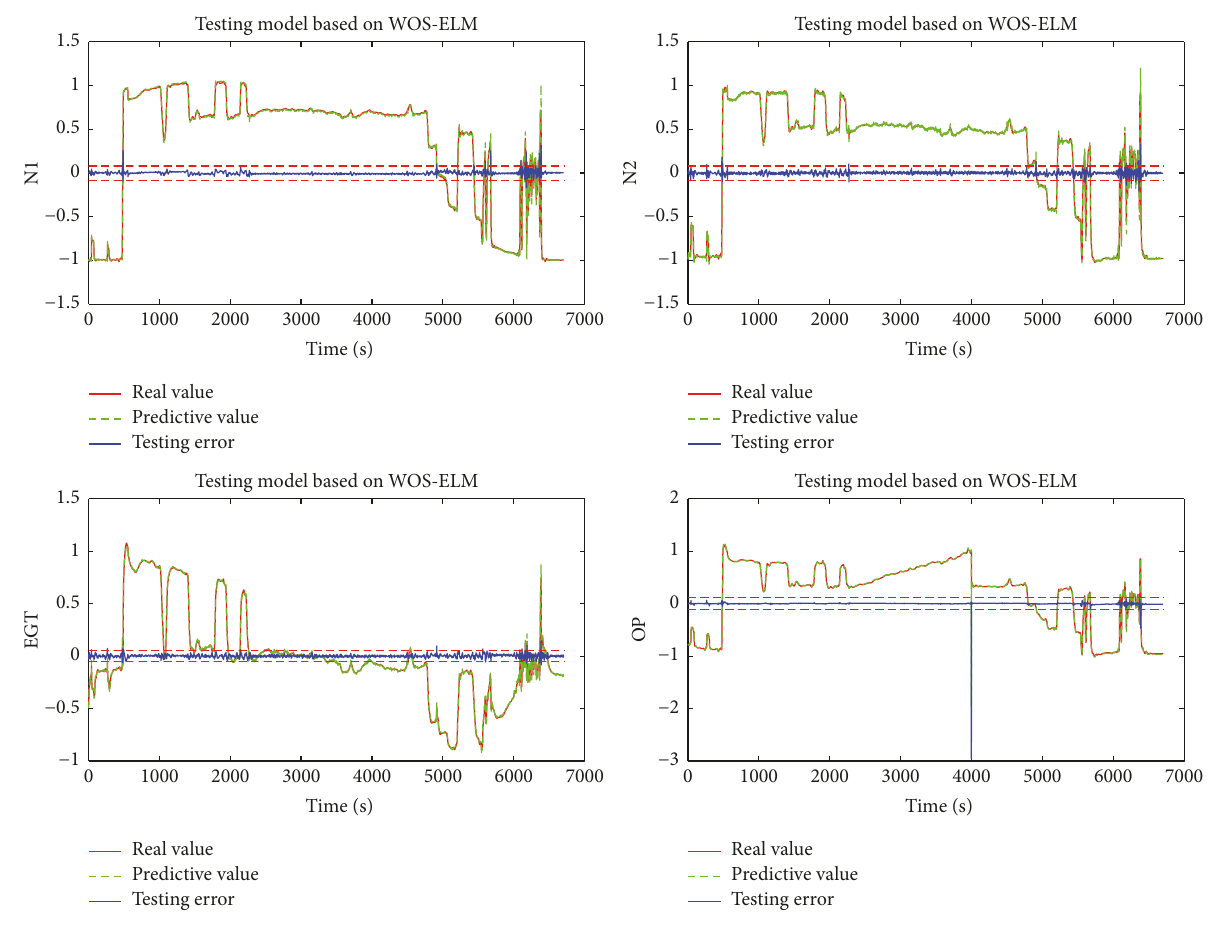
Figure 11: Time redundancy results for soft fault of OP.